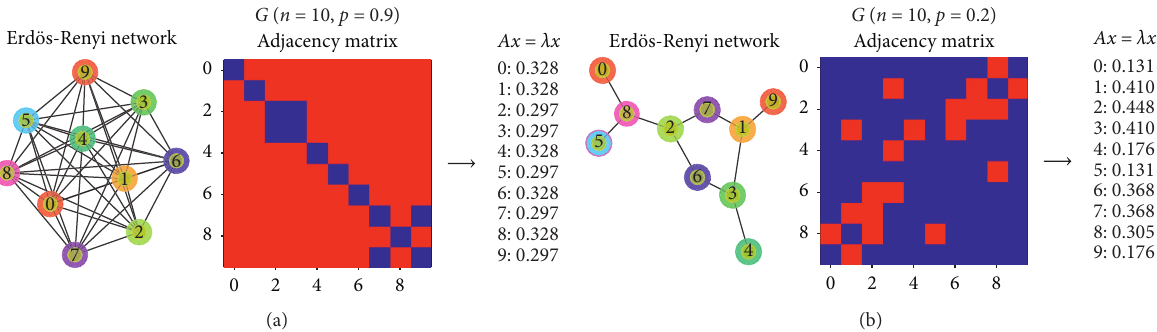
Figure 1: A prototype of the random network with its property. Number of nodes n � 10; connection probabilities p � 0 . 9 (a), p � 0 . 2 (b). At each section, the plots in the left side show the random (Erd¨os-R´enyi) network created. A circle represents each node with an arbitrarily assigned label from 0 to 9, and each line represents a link. The plots of the middle show their adjacency matrix with its entry in row m column n (either 1 � red or 0 � blue) corresponding to its eigenvector centrality (right side at each